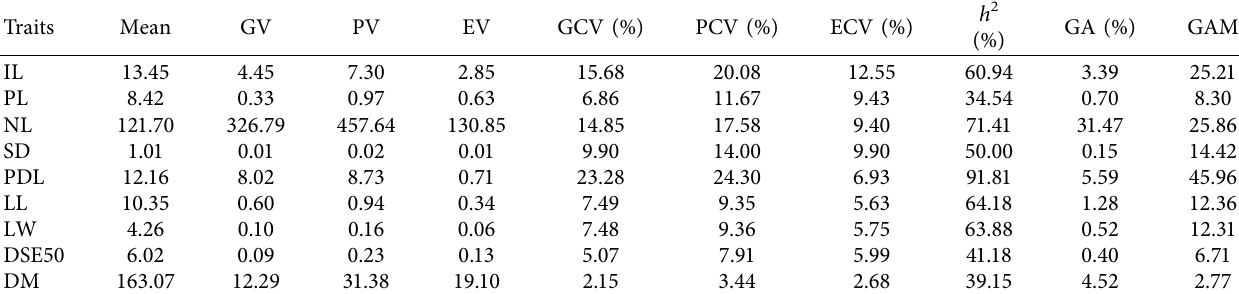
Table 5: Mean and genetic estimates of some vegetative traits of the African yam bean. Traits